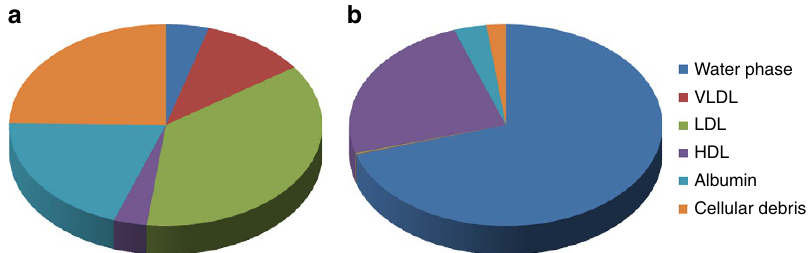
Figure 1 | 3 H-SQGem and 3 H-Gem plasmatic distribution in vitro . The distribution of 3 H among the different plasma fractions was analysed after incubation (5min) of ( a ) 3 H-SQGem NPs or ( b ) 3 H-Gem with human blood. Results are expressed as a percentage (mean values) of total